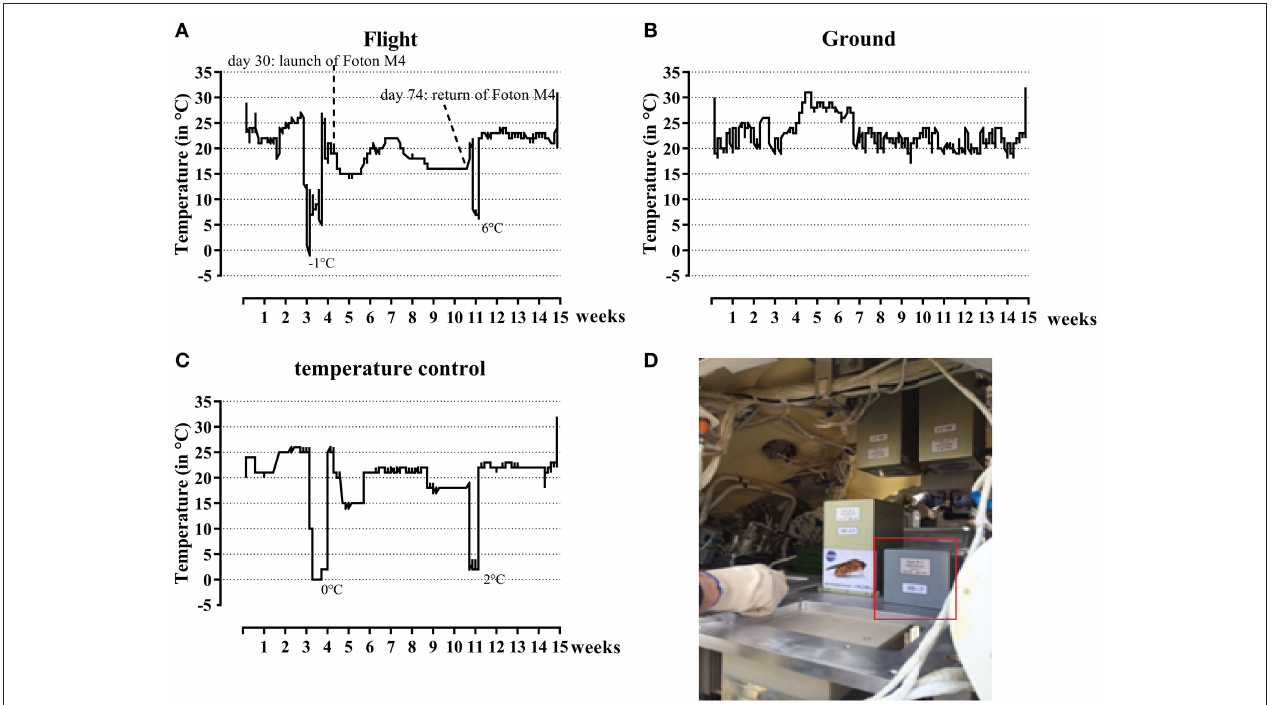
FIGURE 1 | Temperature profiles during the flight experiment and simulated control experiment and its setup in the FOTON capsule. Both during flight (A) and ground (B) temperature profiles were determined. The temperature profile for the flight experiment was later on simulated (C) to determine the effect of these changes on the results. The experiment as set-up in the FOTON capsule is circled in red (D) .